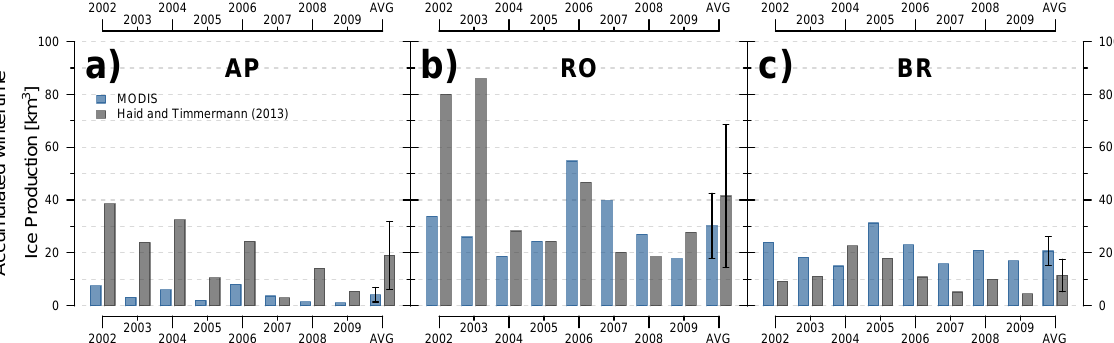
Figure 12. Accumulated wintertime (May to September) ice-production rate (IP, km 3 ) for the years from 2002 to 2009 in the same setup as Fig. 11.